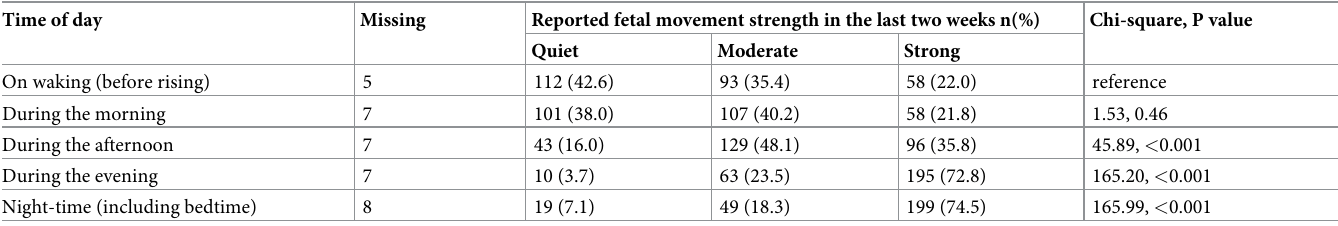
Table 3. Perceived strength of fetal movements and time of day (N = 268).